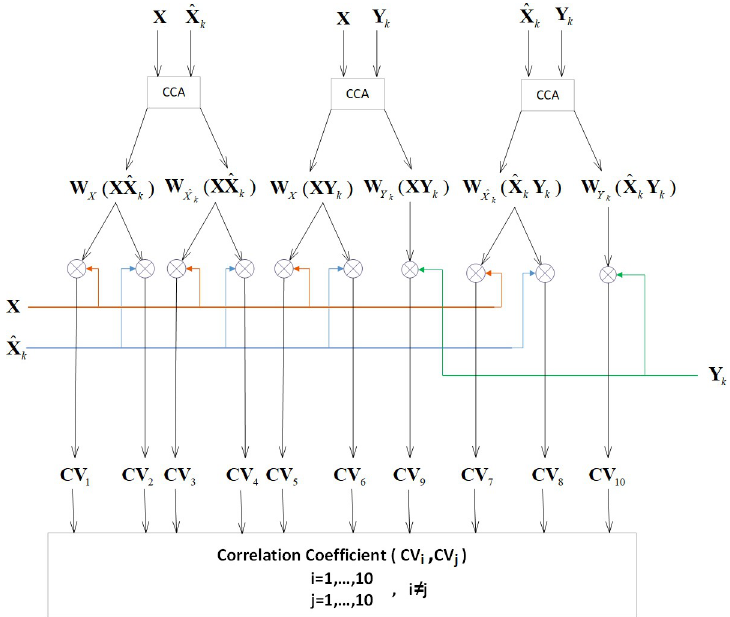
Fig 2. Block diagram for generating all possible CCA-based correlation